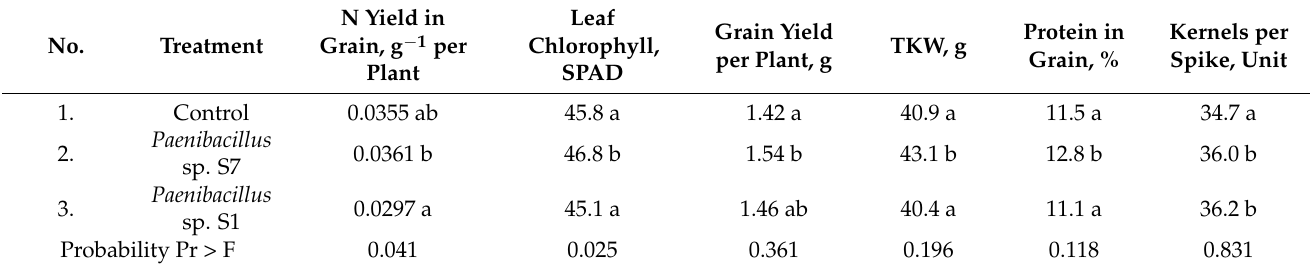
Table 5. Spring wheat productivity and yield quality under the effect of Paenibacillus spp. strains. The values marked with the same letter have no significant differences at p ≤